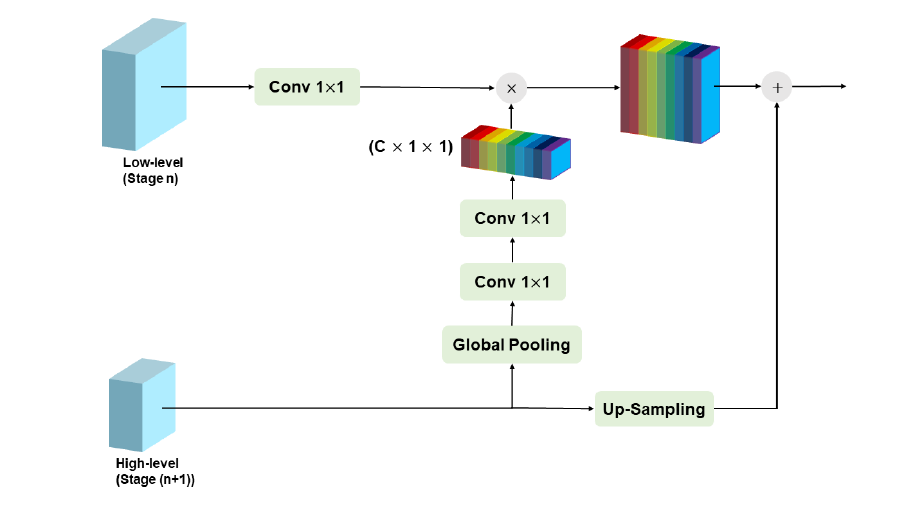
Figure 3. Stage contextual attention mechanism. “Conv” denotes convolutional